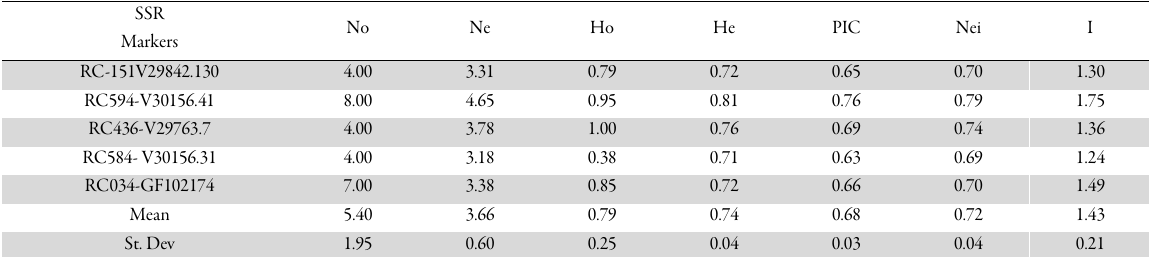
Table 5. Genetic diversity parameters among 5 SSR markers for 20 promising accessions selected from Nigerian castor